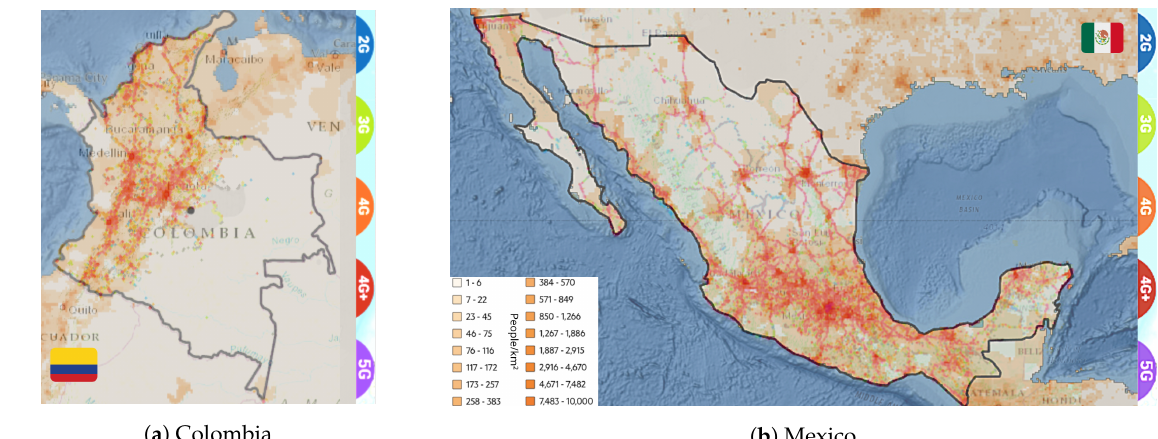
Figure 1. Correlation between population and current mobile network coverage in both study cases.